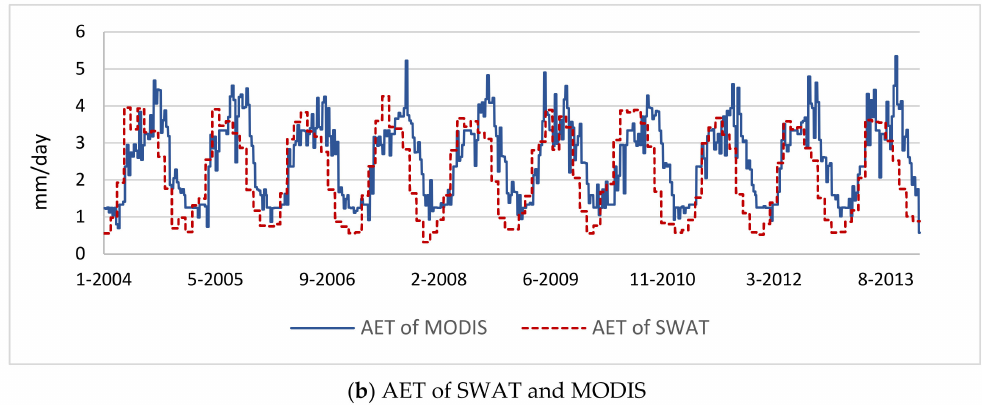
Figure 7. Comparisons of PET ( a ) and AET ( b ) determined with the calibrated SWAT model and MODIS.